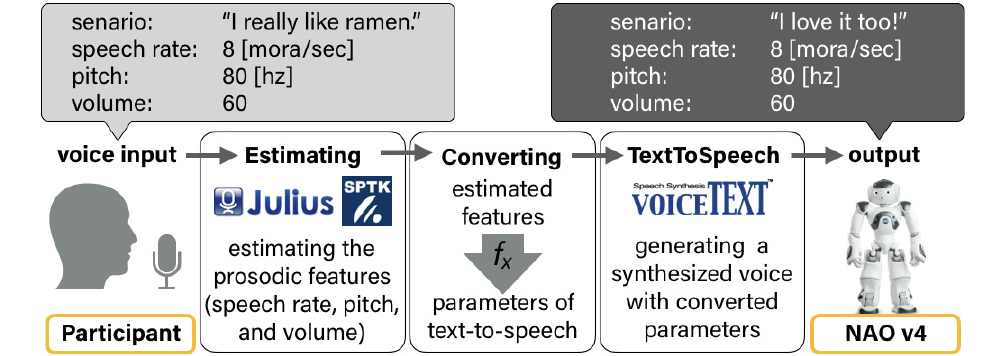
Figure 4. Example of dialog between a participant and the Nao robot in the experiment and system operation flow under the synchronization